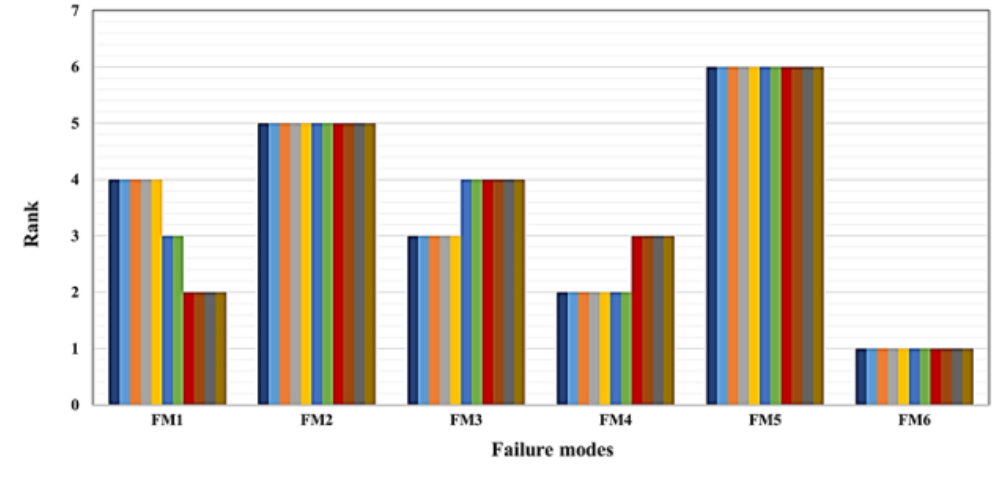
Figure 5. Sensitivity analysis for studied case studies with variable α